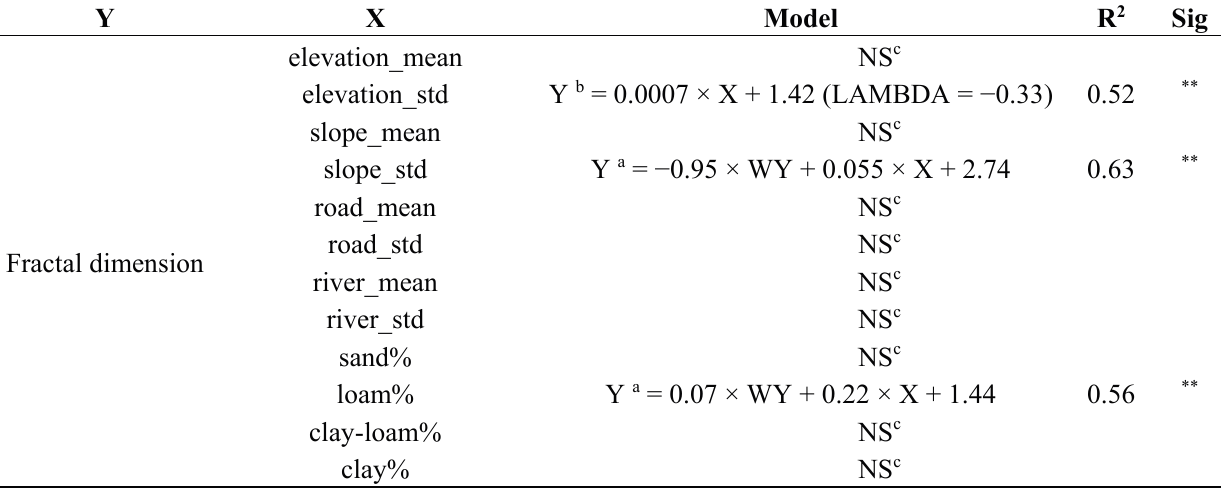
Relationships settlement